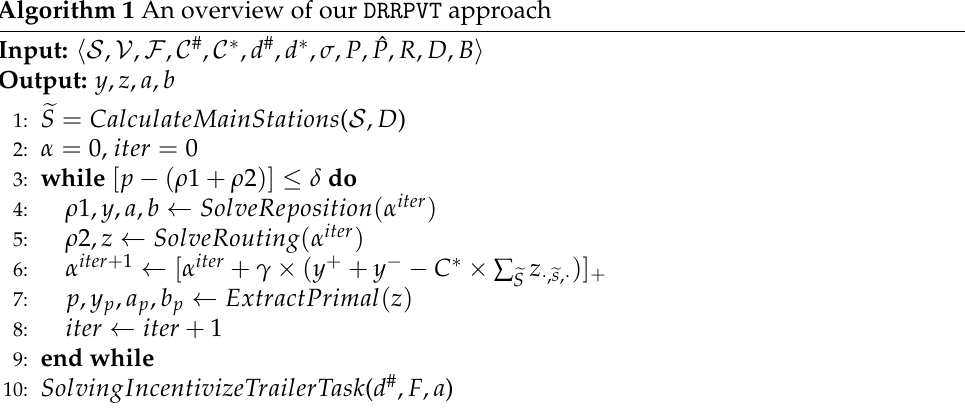
Algorithm 1 An overview of our DRRPVT